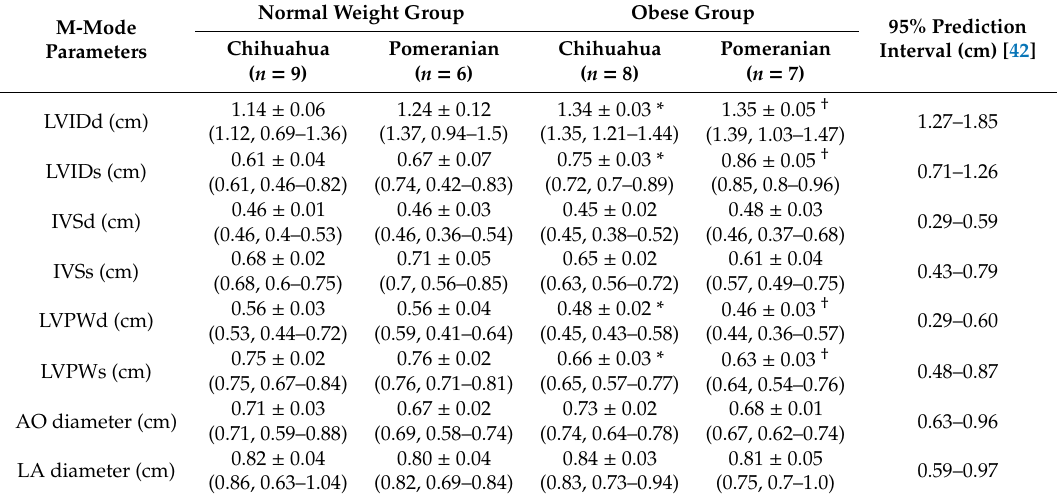
Table 5. Normalization with body weight of M-mode parameters compared between breed in normal weight and obese groups. Mean ± SE (median, minimum–maximum) are reported.